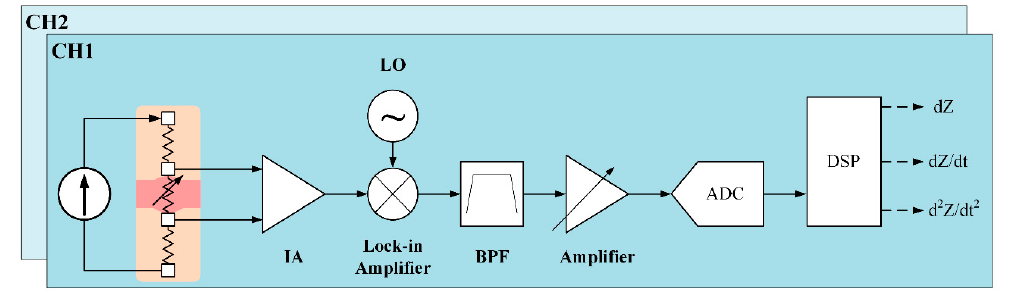
Figure 4. The designed system for two BI measurements in a small body area.